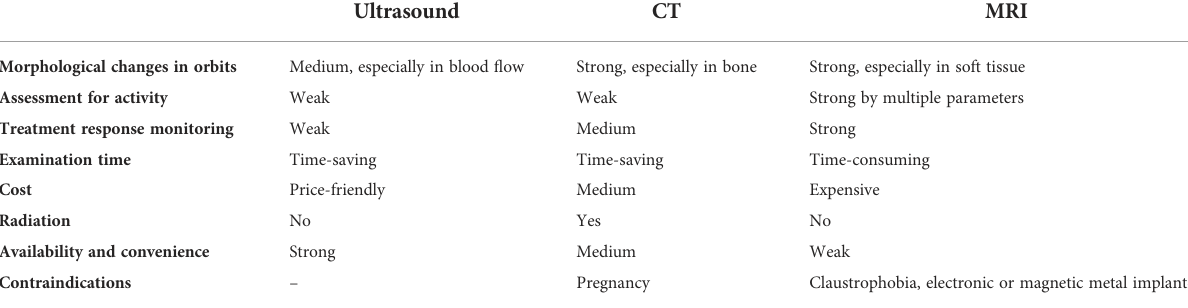
TABLE 1 Comparison of three imaging modalities.